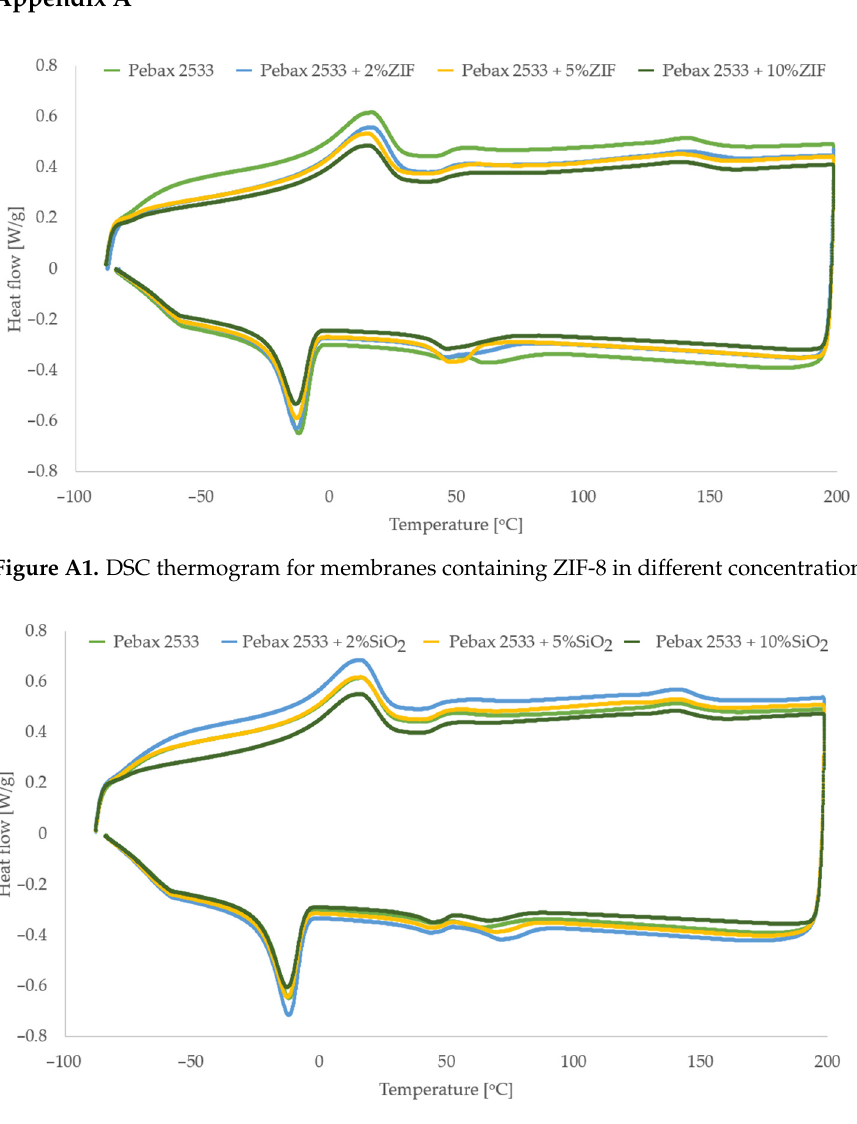
380.3 Table A3. Temperatures at which the weight of the sample decreases by 5 wt% and 10 wt% for a membrane containing different concentrations of POSS-Ph.